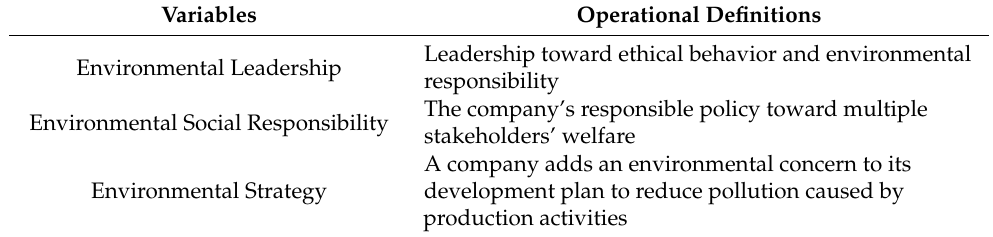
Table 1. Operational Definitions.